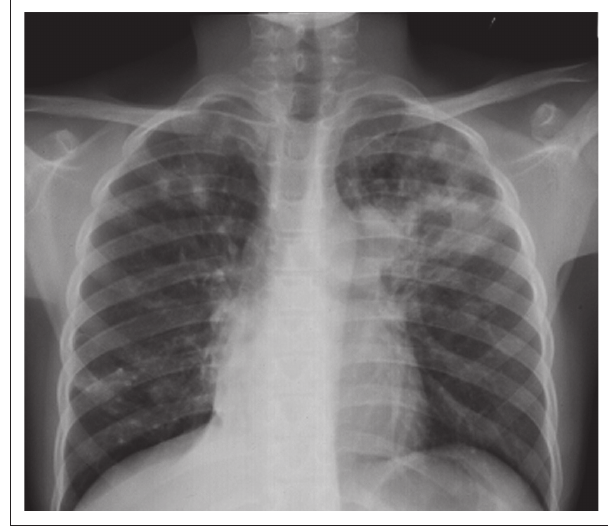
FIGURE 2: Pulmonary multidrug-resistant tuberculosis in an 11-year-old girl. Frontal chest radiograph. Bronchopneumonic opacification and consolidation with cavitation is noted in the left upper lobe. Ill-defined focal consolidation with cavitation is evident in the right upper zone. Dense nodular opacities are noted in the right lower zone, suggesting calcified granulomas. Aortopulmonary window and right hilar lymphadenopathy is noted. Evidence of right lower lobe atelectasis.